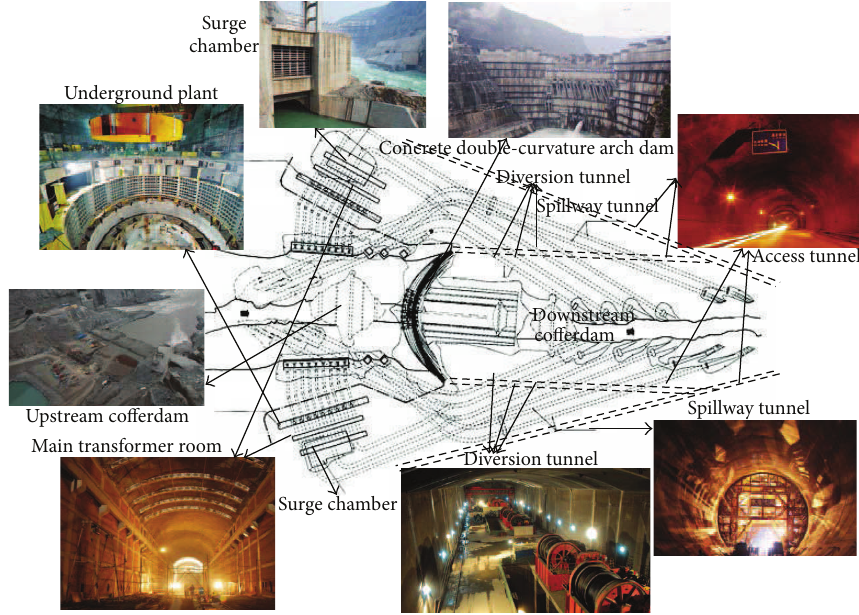
Figure 5: Detailed information of hydropower construction project 𝑋